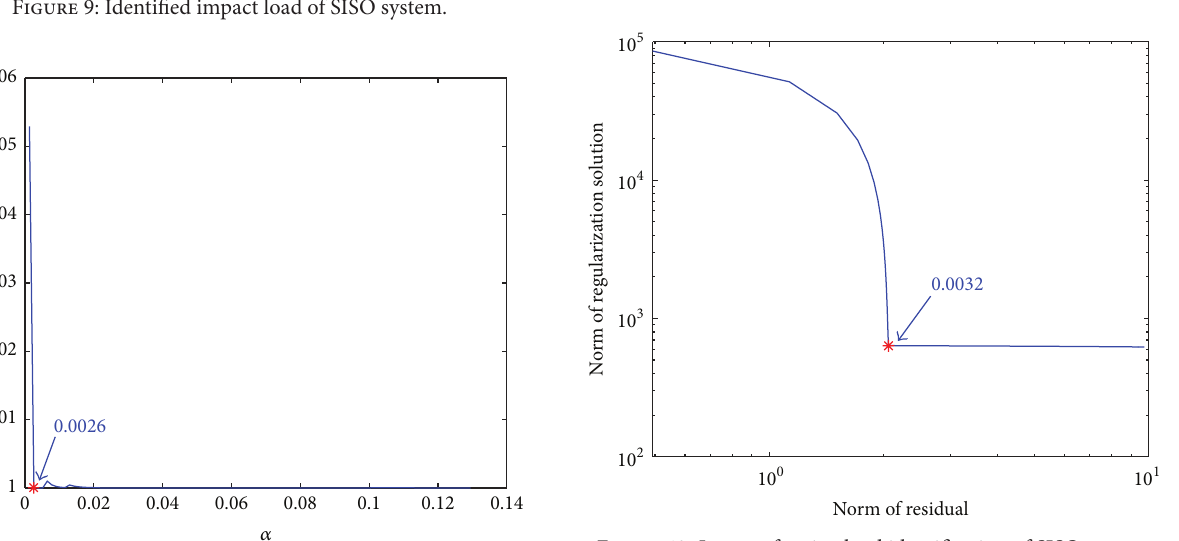
Figure 10: QF for sine load identification of SISO system.